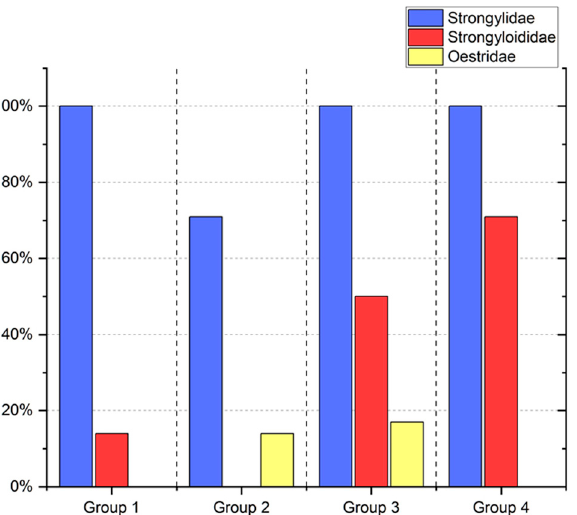
Figure 5. Box whiskers chart of numbers of eggs/larvae of parasites in stool samples of Arabian horses and Thoroughbreds.